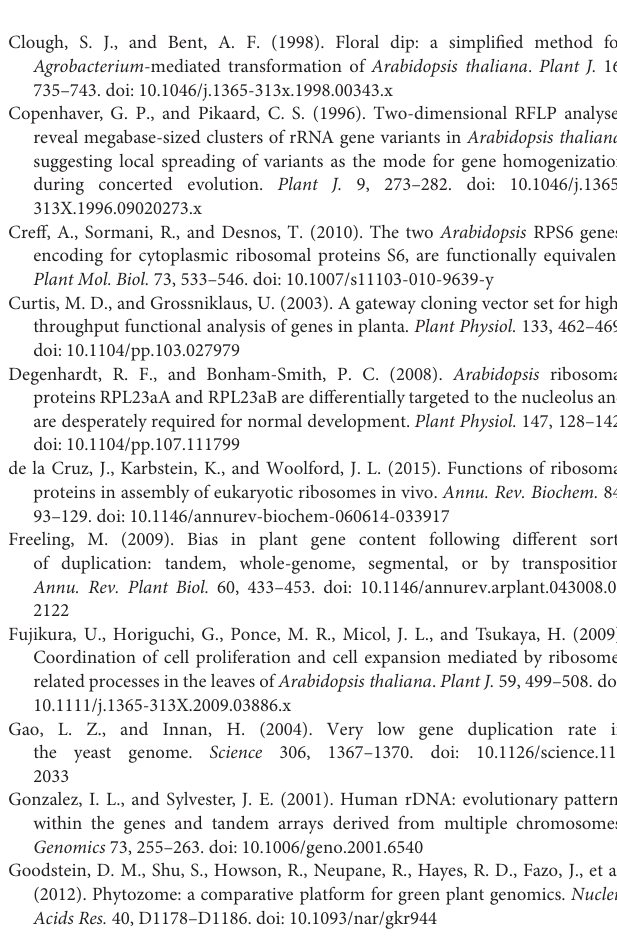
FIGURE S2 | Tandem C. grandiflora RPL9 genes. Nucleotide sequence of CagraRPL9C1 (solid underline) and CagraRPL9C2 (dotted underline) genes.